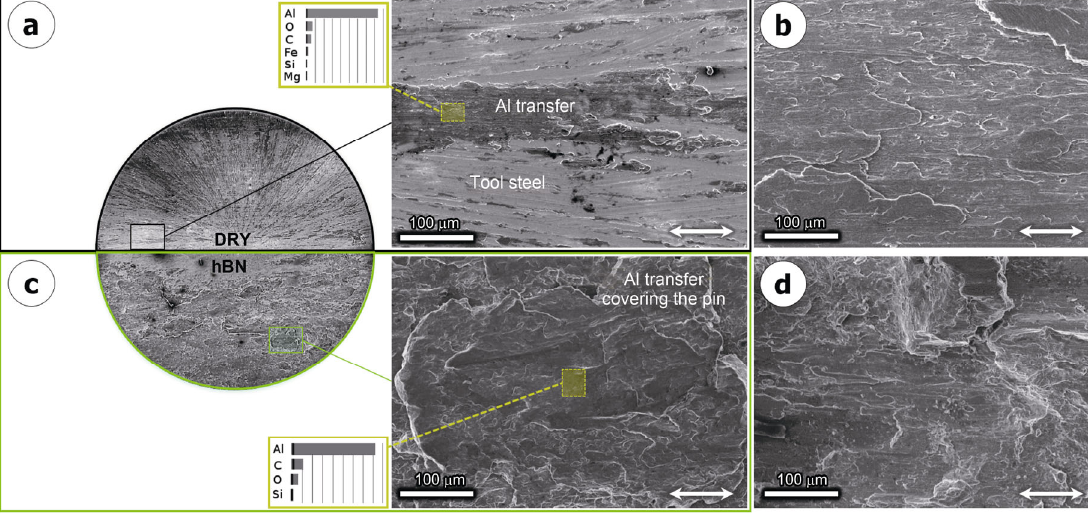
Fig. 8 SEM micrographs of the (a) pin and (b) aluminium surface after a dry sliding test vs. (c) pin and (d) aluminium surface after a hBN lubricated test, both using as-received tool steel O at 30× and 200× magnification ( ↔ indicates the sliding